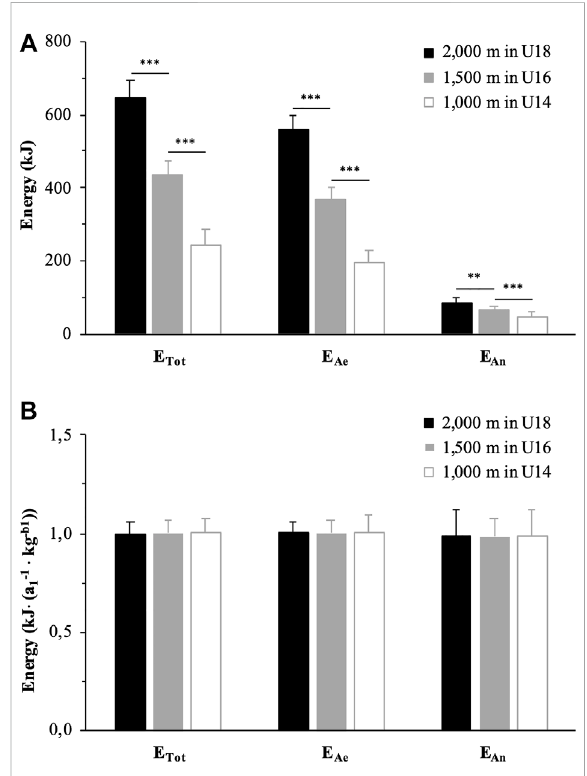
FIGURE 1 Quantity of energy released from metabolic pathways during the exhaustive rowing ergometer exercise over 2,000 m in rowers under18 years(U18,black),1,500 minrowersunder16 years(U16, grey) and 1,000 m in rowers under 14 years (U14, white) expressed in absolute values (A) and allometrically scaled for body mass (B) .**and***:signi fi cantlydifferentat p < 0.01and p < 0.001, respectively. E Tot : total amount of energy released; E Ae : amount of energy released from aerobic metabolism; E An : amount of energy released from anaerobic pathways; a 1 and b 1 : simple allometric model parameters.